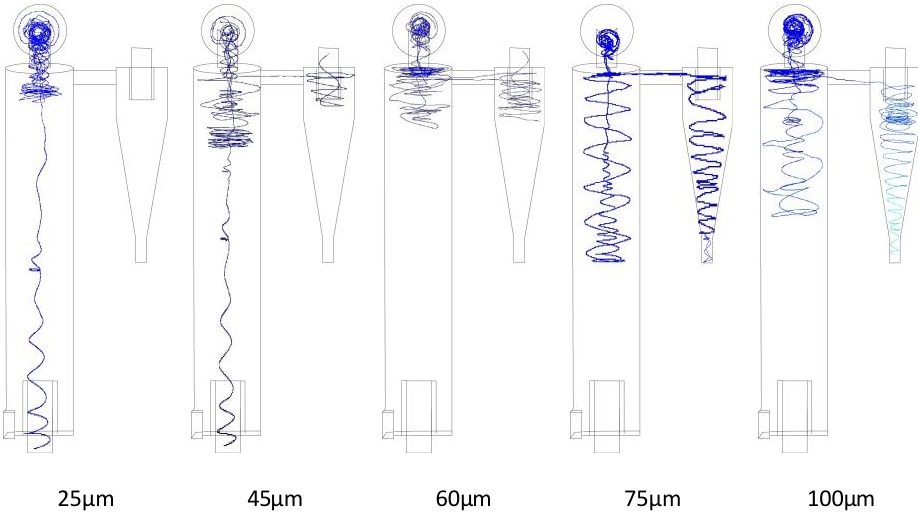
Figure 8. Trajectories of different particles in the hydrocyclone sand washer.